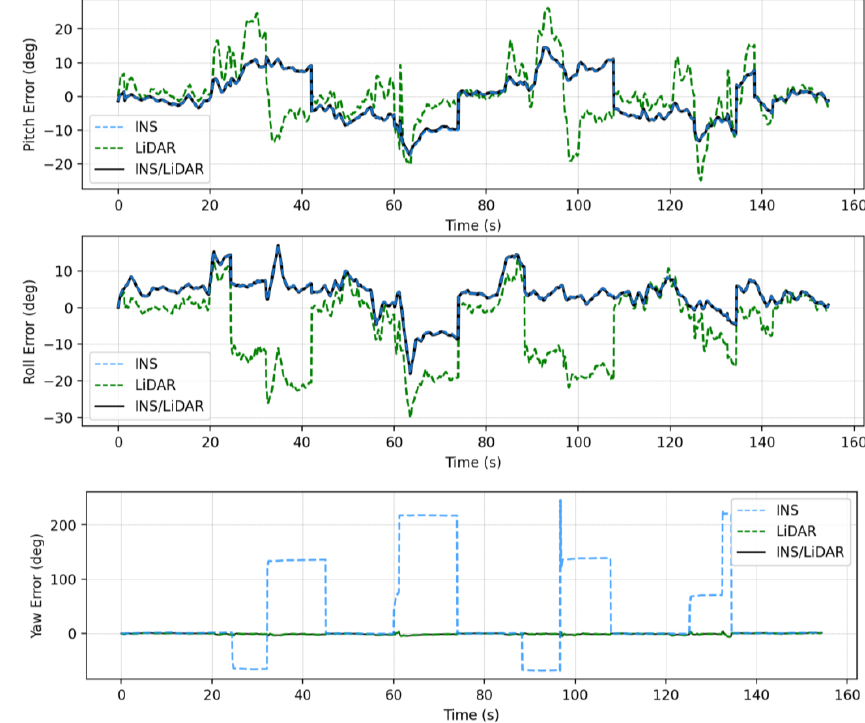
Figure 14. GNSS assisted: errors of attitude angles (roll, pitch, and yaw).